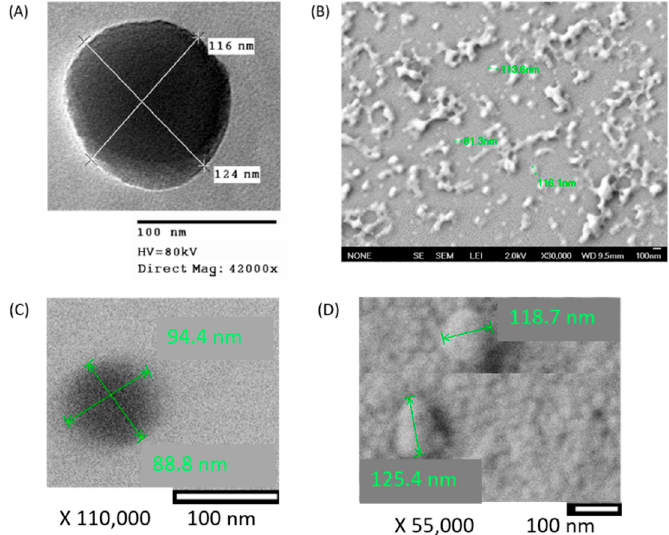
Figure 2. Transmission and scanning electron micrographs of drug encapsulated PLGA-PEG nanoparticles. ( A ) Transmission electron microscopy (TEM) of gefitinib in PLGA-PEG NPs. HV: High Voltage. ( B ) Scanning electron microscopy (SEM) of gefitinib in PLGA-PEG NPs ( C ) TEM of combination nanoparticles (NPs) ( D ) SEM of combination NPs. Also seen in the background are the gold particles (small raised structures) that are sputter coated on the silicon wafer.